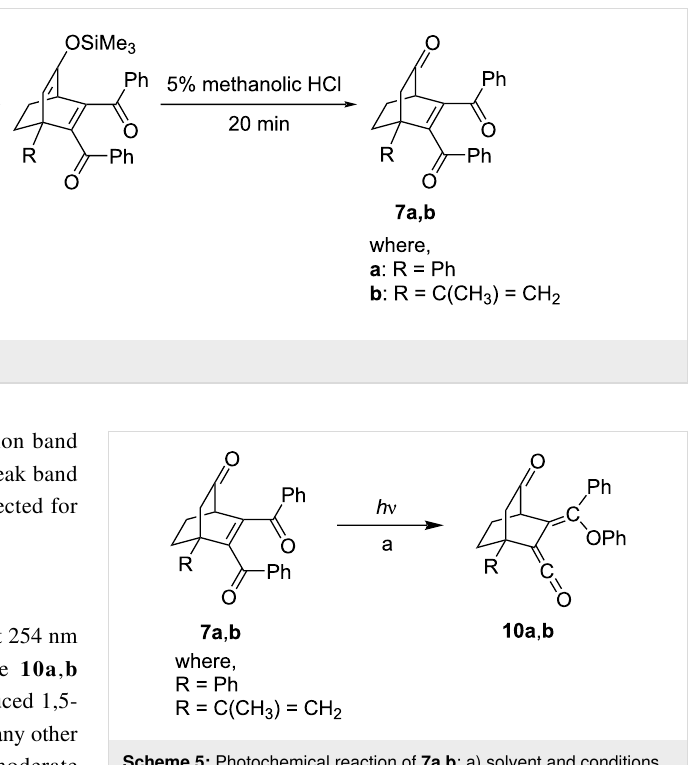
Scheme 5: Photochemical reaction of 7a , b ; a) solvent and conditions are given in Table